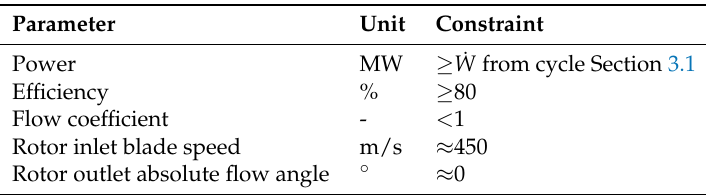
Table 1. Design space explorer